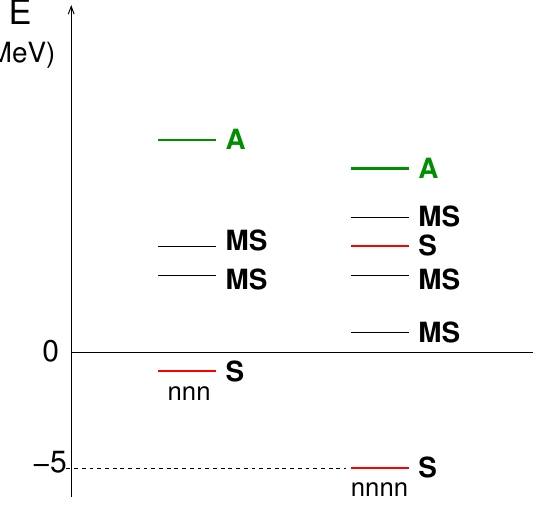
Figure 3: Schematic low level ordering of 3n and 4n in OH basis displaying the first symmetric (S) antisymmetric (A) and mixed-symmetry (MS) excitations.